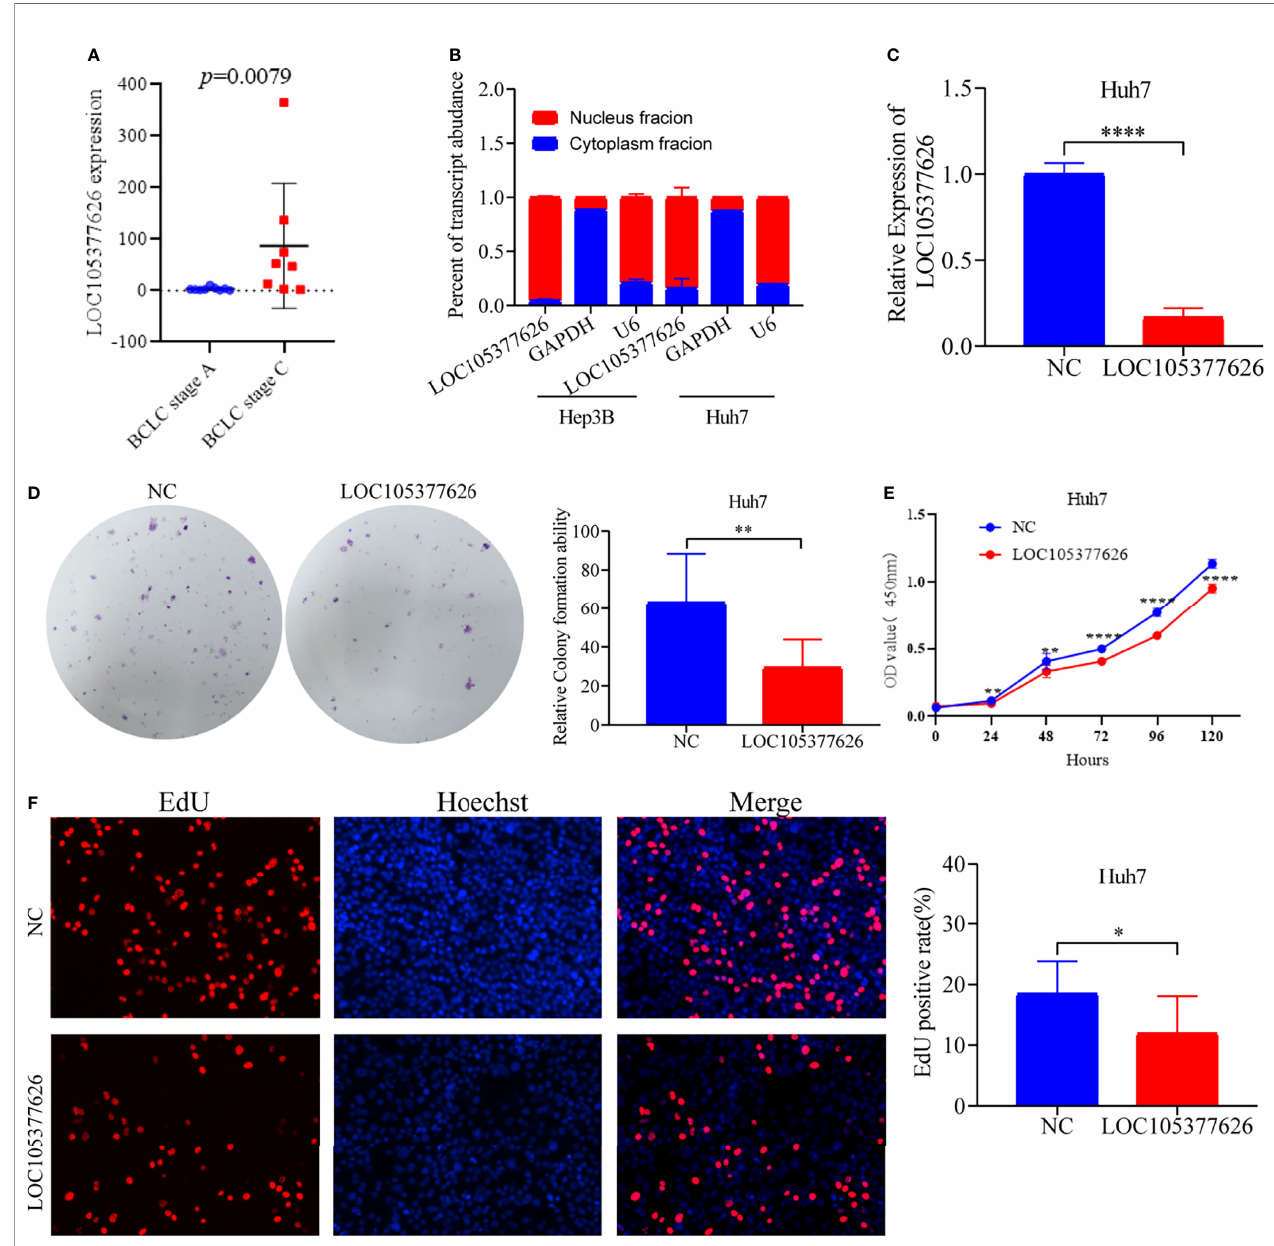
FIGURE 9 | Differential expression, cellular location, and in vitro experiments of LOC105377626. (A) Differential expression of LOC105377626 between TNM stage A and stage C, (B) Cellular location results of LOC105377626 in Hep3B and Huh7 cell lines, (C) Relative expression of LOC105377626 in control and knockdown groups, (D – F) Results of colony formation, CCK-8 and EdU assays between LOC105377626 control and knockdown groups. * means P<0.05. ** means P<0.01.**** means